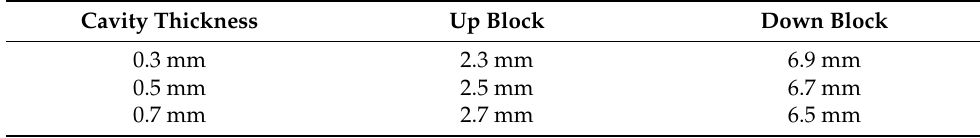
Table 1. Cavity thickness and block